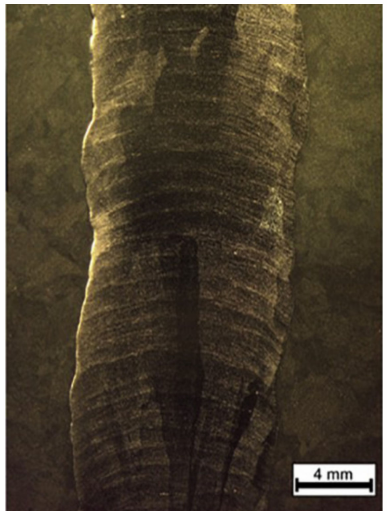
Figure 21. Microstructure showing epitaxial growth of columnar grains in build direction. Reprinted with permission from Ref. [65]. Copyright 2019